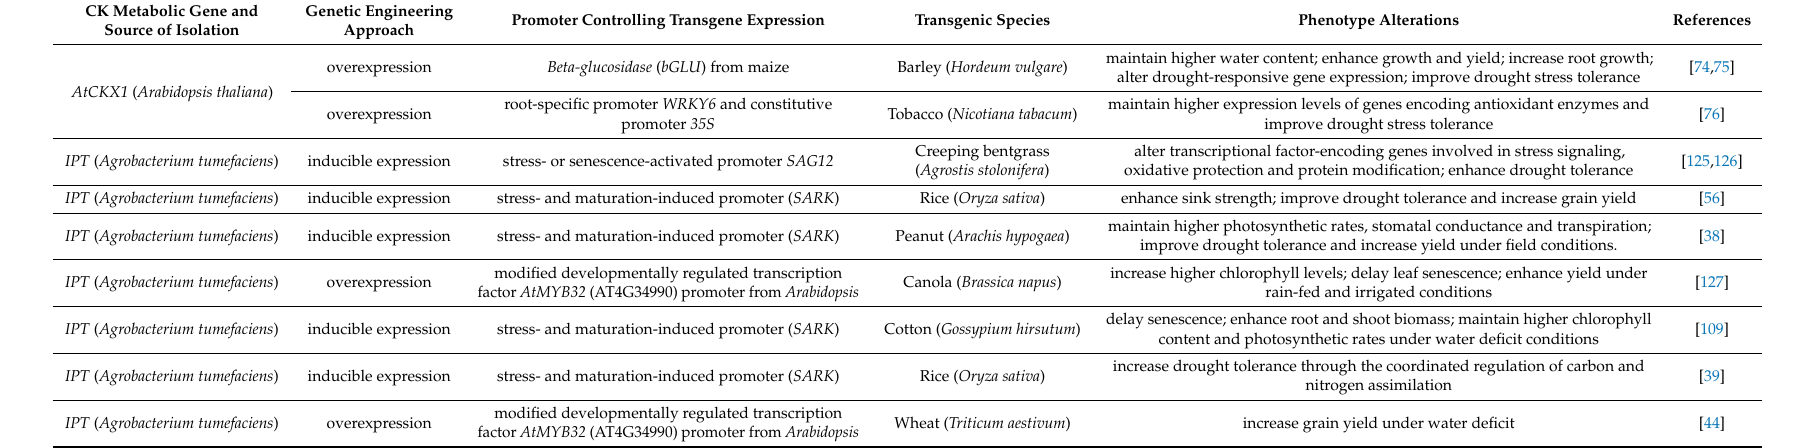
Table 1. Summary of cytokinin (CK) modification-related studies and their reports on corresponding drought-tolerant